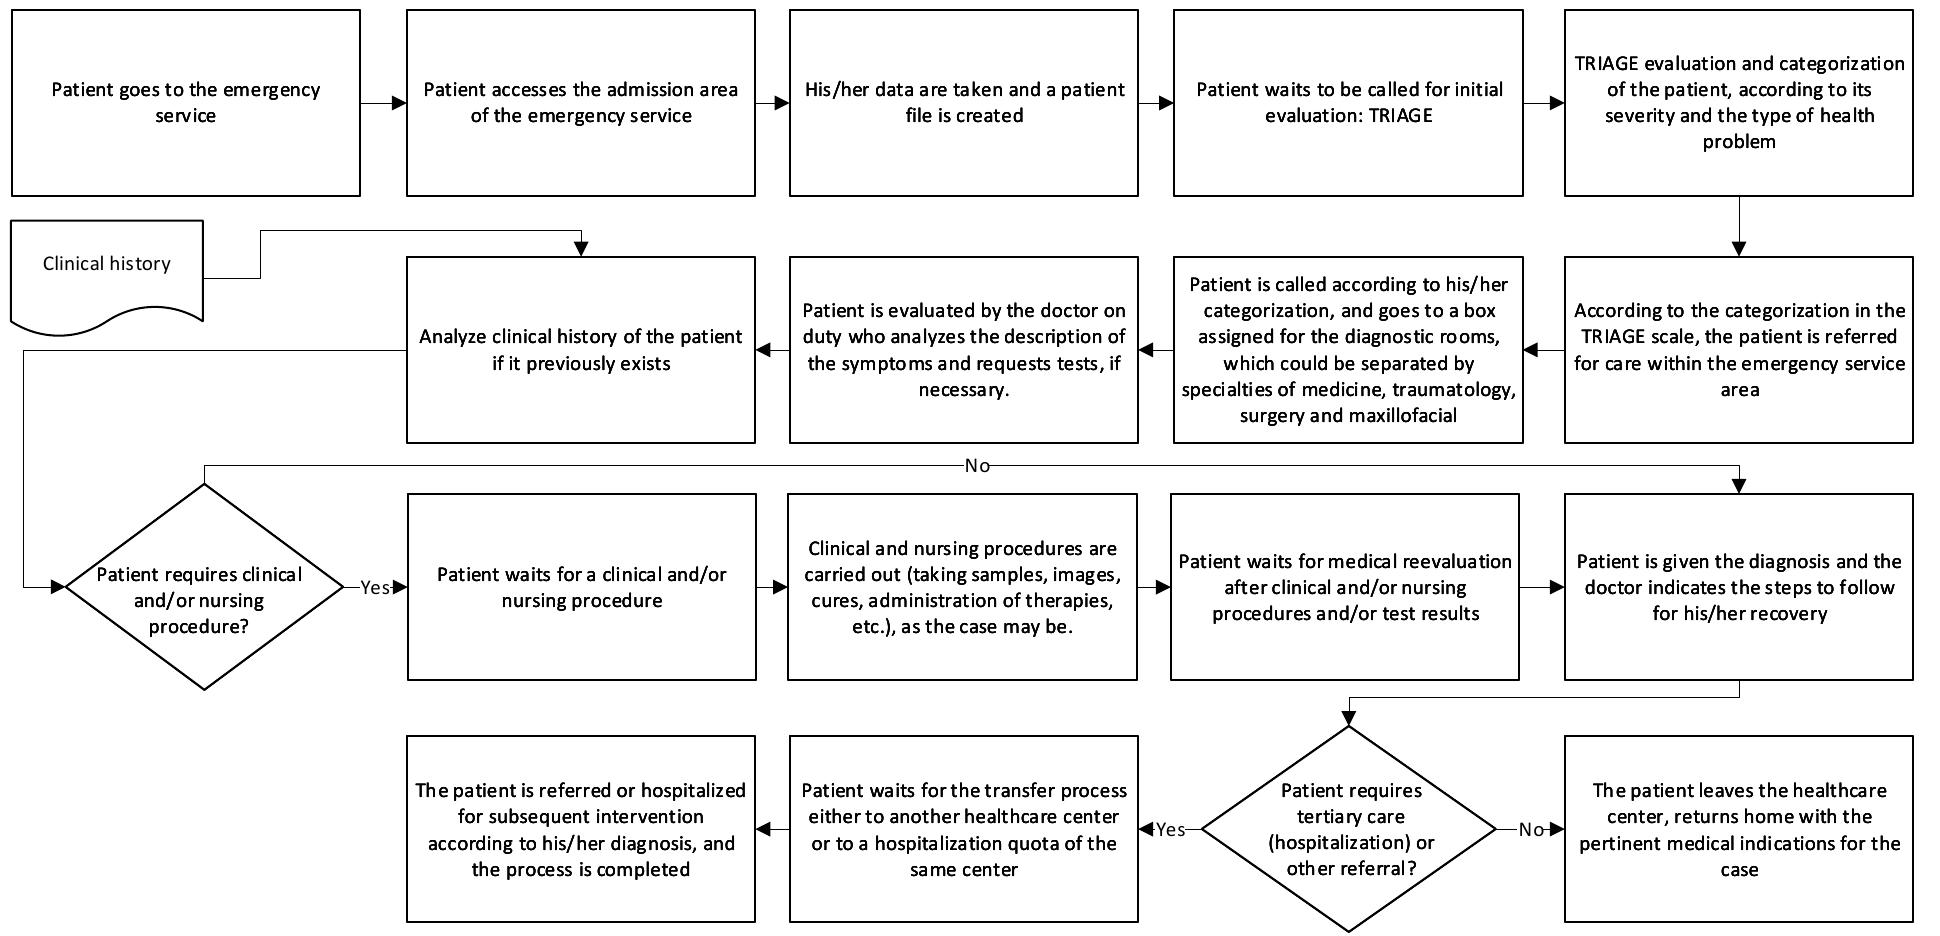
Figure 2. Activities in an average emergency